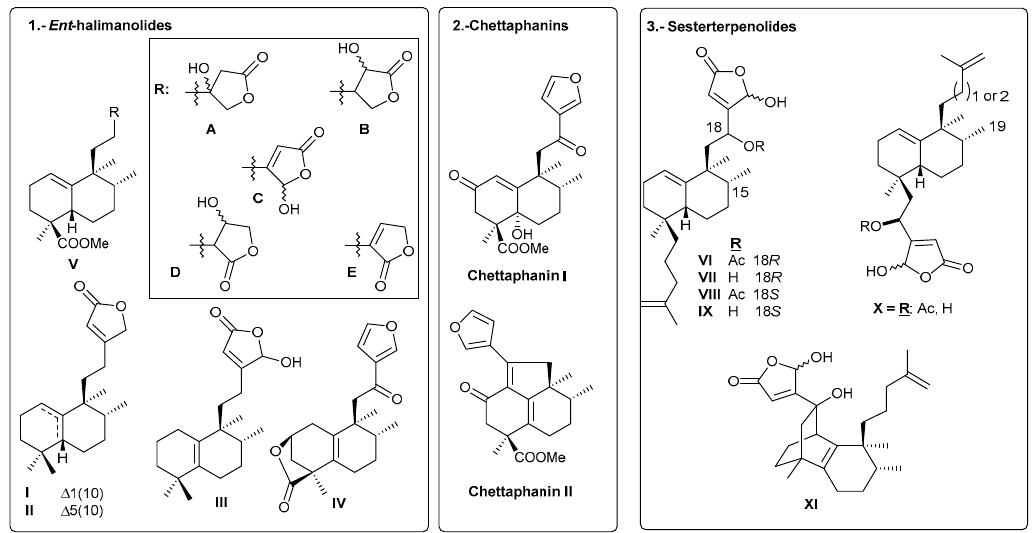
Figure 5. Ent -halimanolides, chettaphanins, and sesterterpenolides obtained from 2 . Molecules 2019 , 24 , x FOR PEER REVIEW